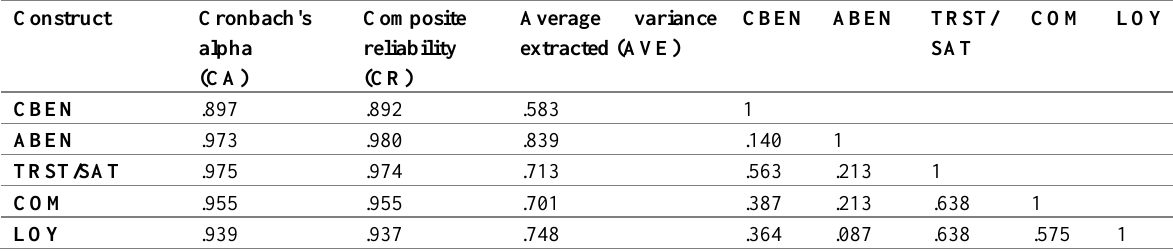
Table 2: Validity and Reliability Figures for Final